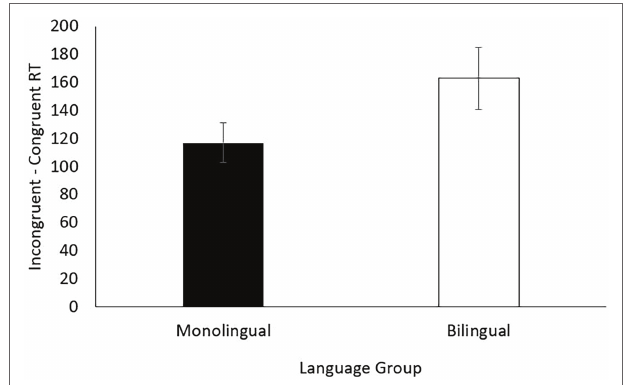
FIGURE 2 | Mean and SE for incongruent trials accuracy in the flanker task (inhibitory control).